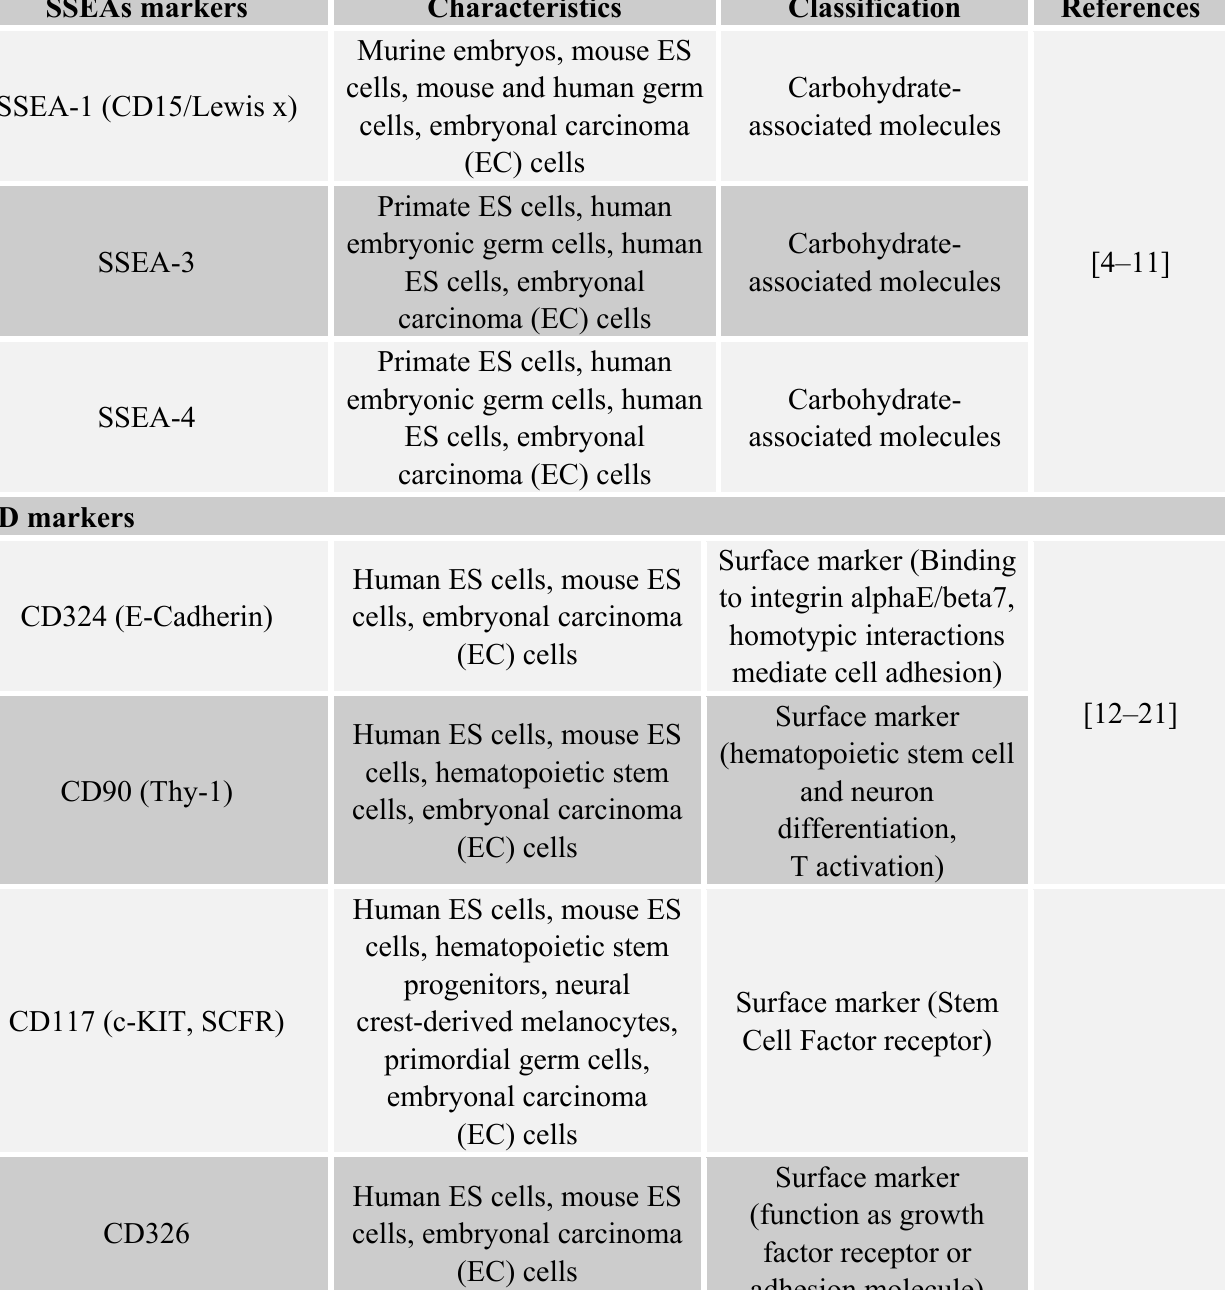
Table 1. ESC surface